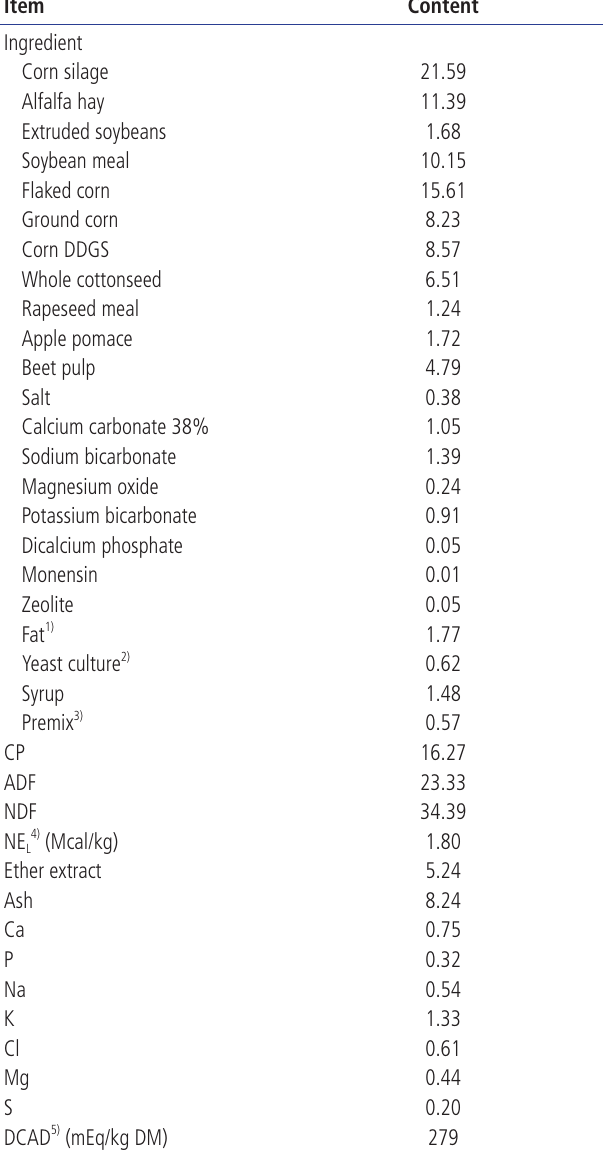
Table 1. Ingredient and chemical composition of basal diets (% of